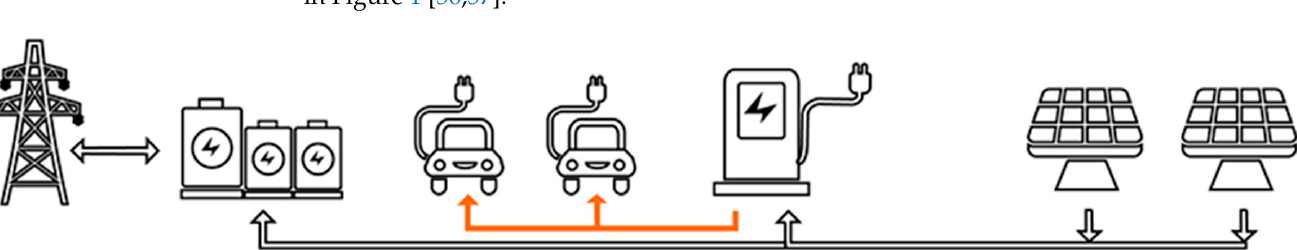
Figure 1. Electricity supply and reception infrastructure.